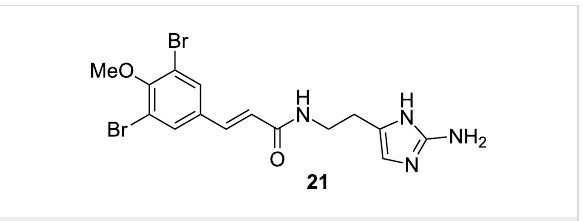
Figure 6: Bromotyrosine alkaloid ( 21 ) isolated from the sponge Verongula sp.